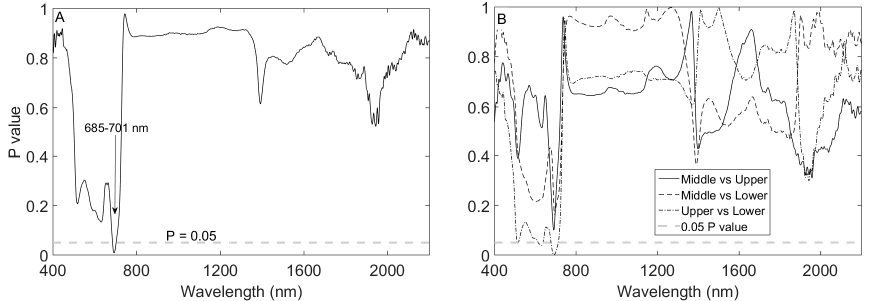
Figure 3. Variation in leaf spectral reflectance at different canopy positions for the pooled dataset (ANOVA test) ( A ); and pairwise variation in leaf spectral reflectance at different canopy positions ( B ).